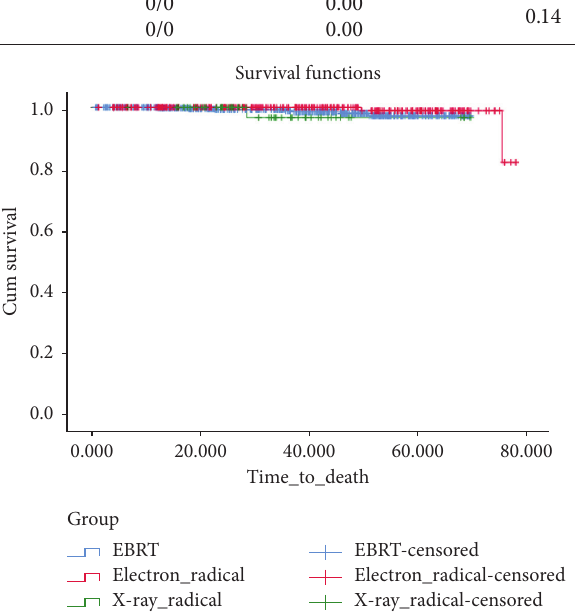
Figure 3: Cumulative incidence of disease-free survival in the radical groups in comparison with EBRT.